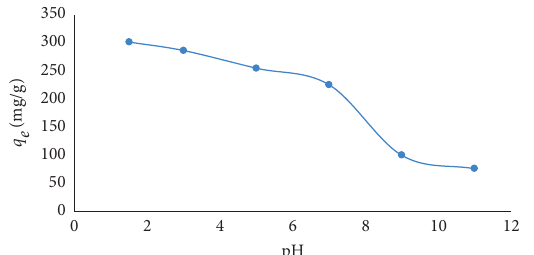
− ions sorption by 4